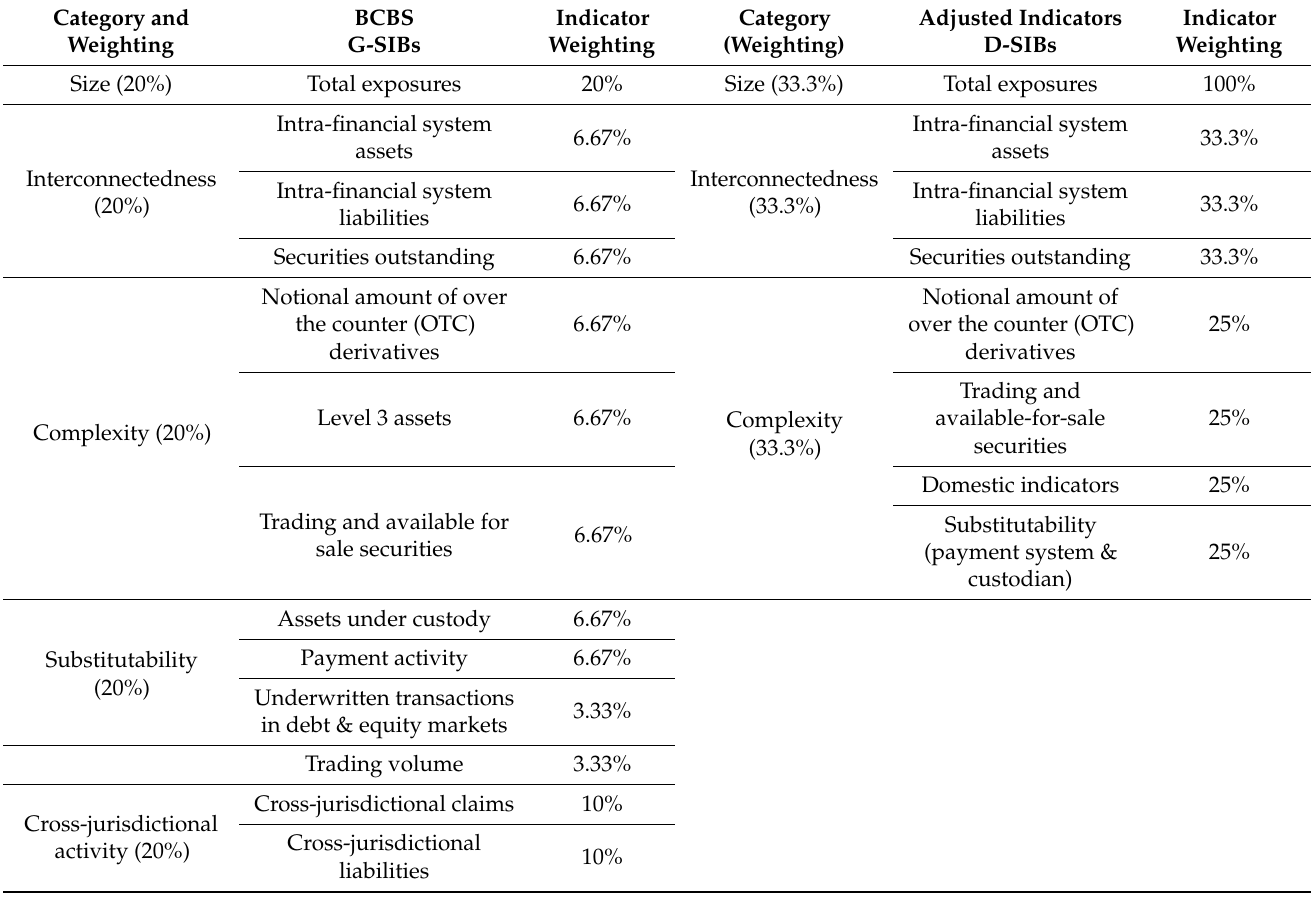
Table 14. Basel and OJK